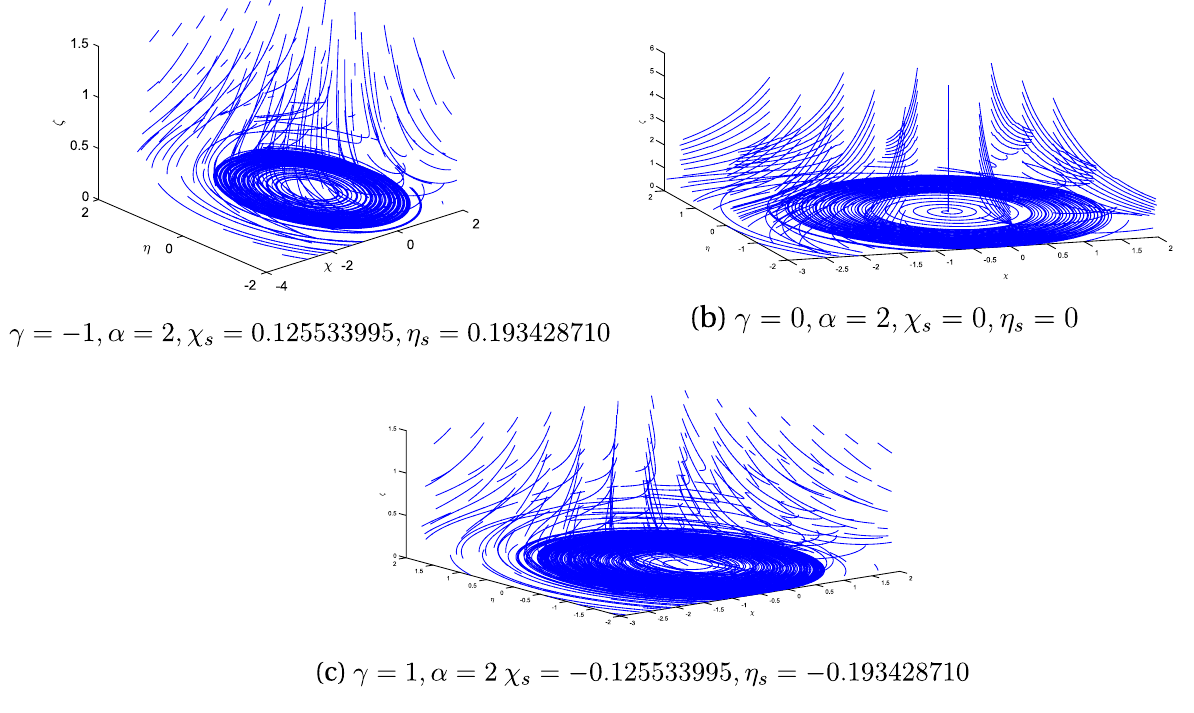
Figure 3. Streamlines for M = 2 with variation in rotation parameter α and obliqueness parameter γ . .